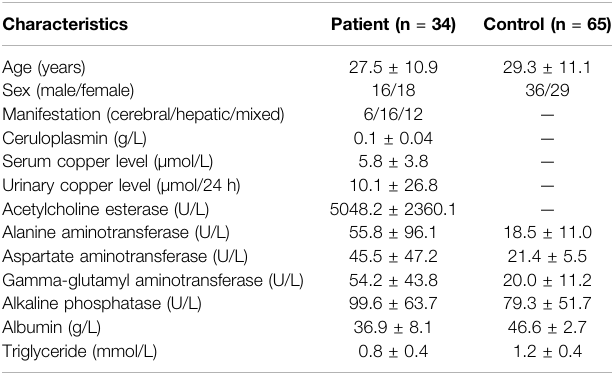
TABLE 1 | Baseline characteristics of